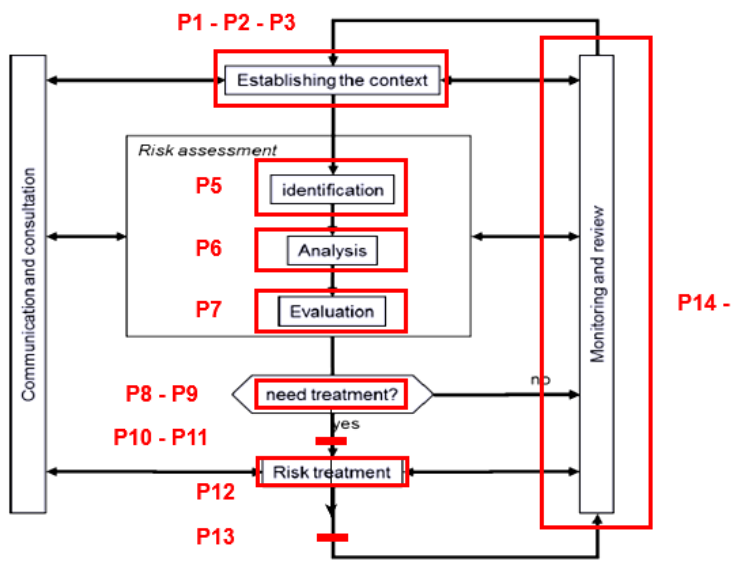
Figure 6. Integration of ENISA’s guidelines [86] to